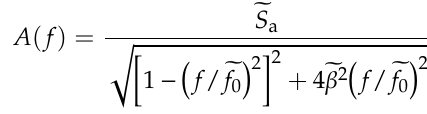
Figure 6. Amplitude and phase responses with associated uncertainties.